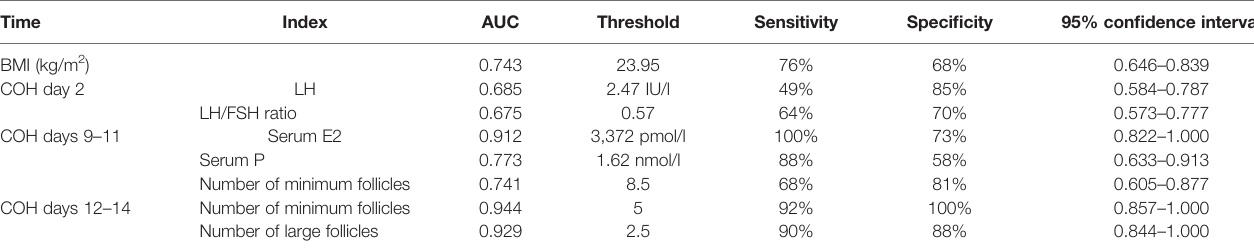
TABLE 3 | Results of single-factor indexes during the COH process in the ultra-long/long group patients.